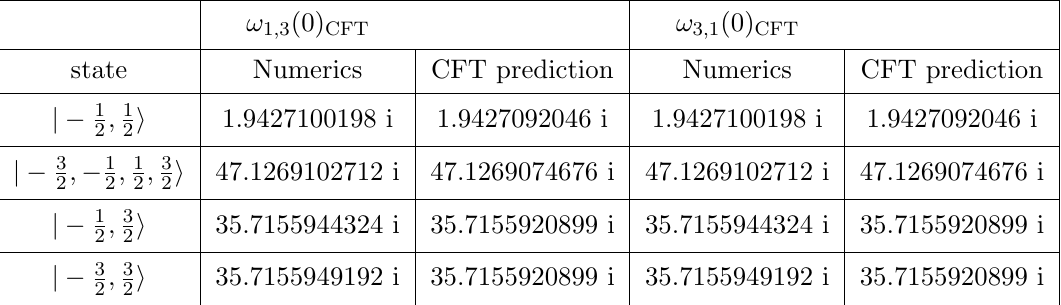
Table 3 . Numerical data for the expectation values of the level 4 descendants of the unity, at the (cid:0) (cid:1) (cid:23) = 4 ; ‘ = 10 (cid:0) 2 point of the parameter space. 7 Before turning to the case of ! (0) , from (7.8) and (7.9) taken at (cid:1) 3 ; 1 CFT